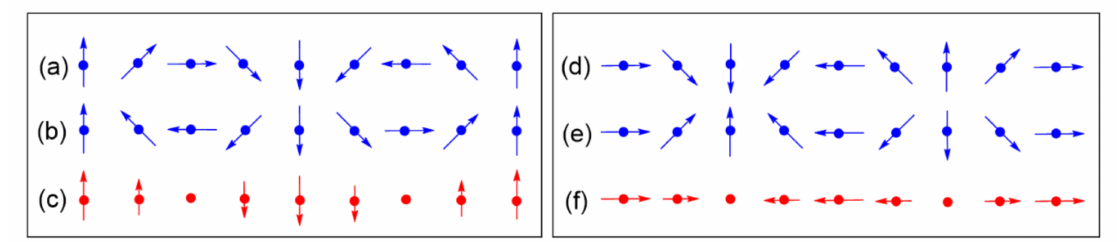
Figure 15. The superposition of the two chiral cycloids in ( a ); ( b ) leads to the transverse SDW in ( c ). The superposition of the two chiral cycloids in ( d ); ( e ) leads to the longitudinal SDW in ( f ). For ease of illustration, the angle of the spin rotation was taken to be 45 ◦